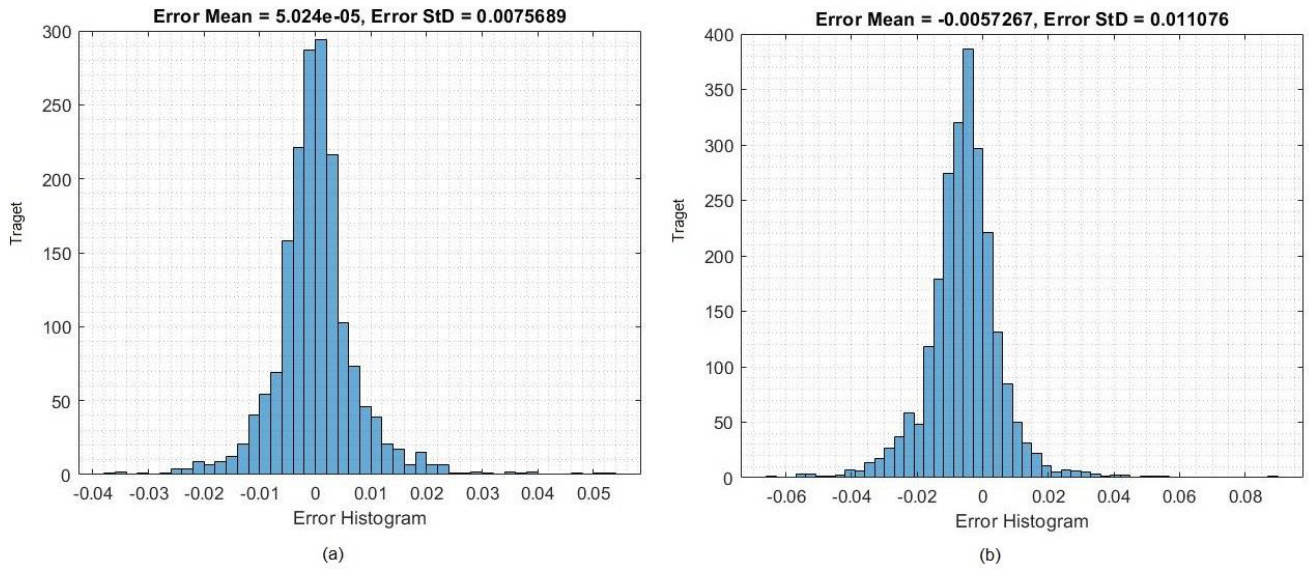
Figure 11. Histogram of the deep learning models ( a ) CNN-LSTM and ( b ) LSTM for predicting the Apple stock market closing price during the training phase.